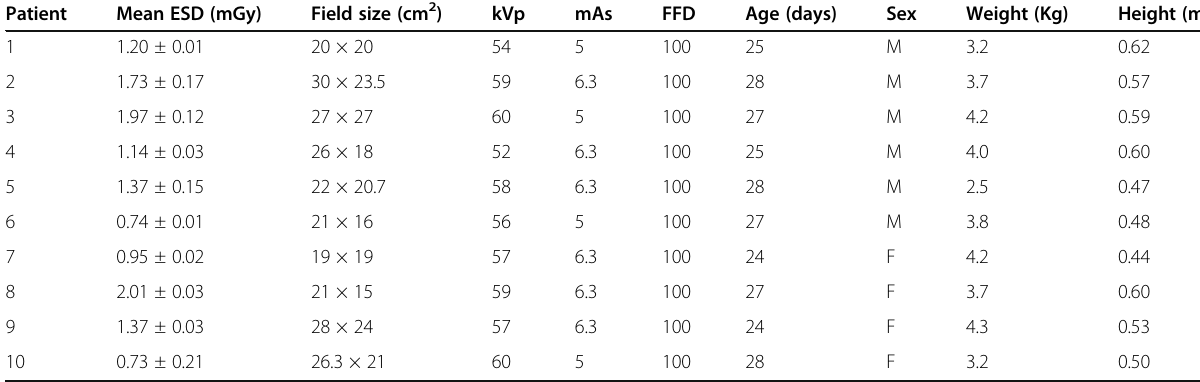
1.09 ± 0.43 mGy, and the ESD at 50th and 75th percentiles ± 0.46 mGy and 1.05 ± 0.46 mGy respectively. The mean field size, kVp, mAs, FFD, age, weight, and height for the 10 newborns within the age group were 461 ± 156.46 cm 2 , 56.3 ± 2.11kVp, 5.78 ± 0.67mAs, 100 ± 1.35 cm, 3.6 ± 2.46 years, 2.63 ± 0.85 kg, and 0.46 ± 0.07 m respectively. A one- way ANOVA post hoc test shows that doses (mGy) were affected by FFD ( P < 0.001) and field sizes ( P < 0.001). Pa- rameters that did not affect the dose were kVp ( P = 0.346), mAs ( P = 1.000), age ( P = 1.000), weight ( P = 1.000), and height ( P = 1.000) respectively (Table 2). Table 5 Entrance surface dose (ESD) and other parameters for newborn between 22 and 28 days Patient Mean ESD (mGy) Field size (cm 2 ) kVp mAs FFD Age (days)